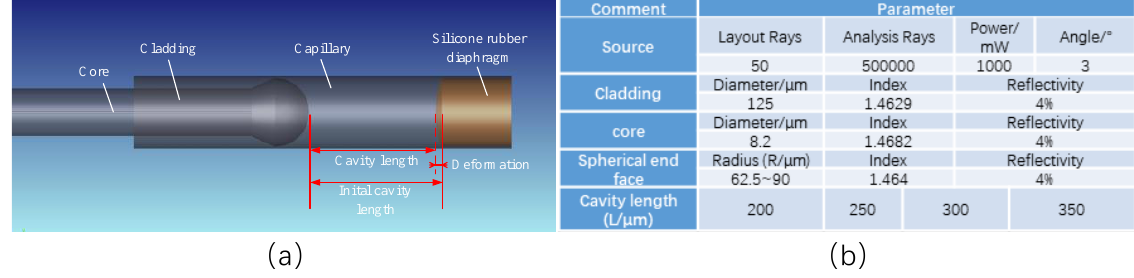
Figure 7. A 3D diagram of simulation model in ZEMAX. ( a ) the physical model of the silicone rubber pressure sensor; ( b ) simulation parameters.